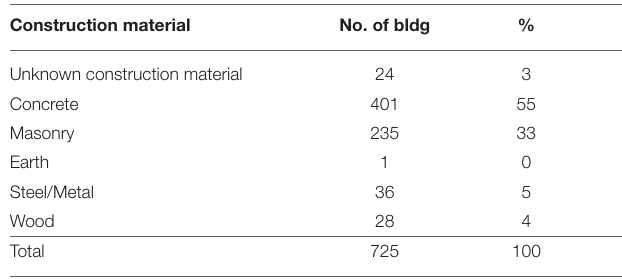
TABLE 1 | Surveyed buildings in different age band of construction. TABLE 2 | Surveyed buildings in different construction material.